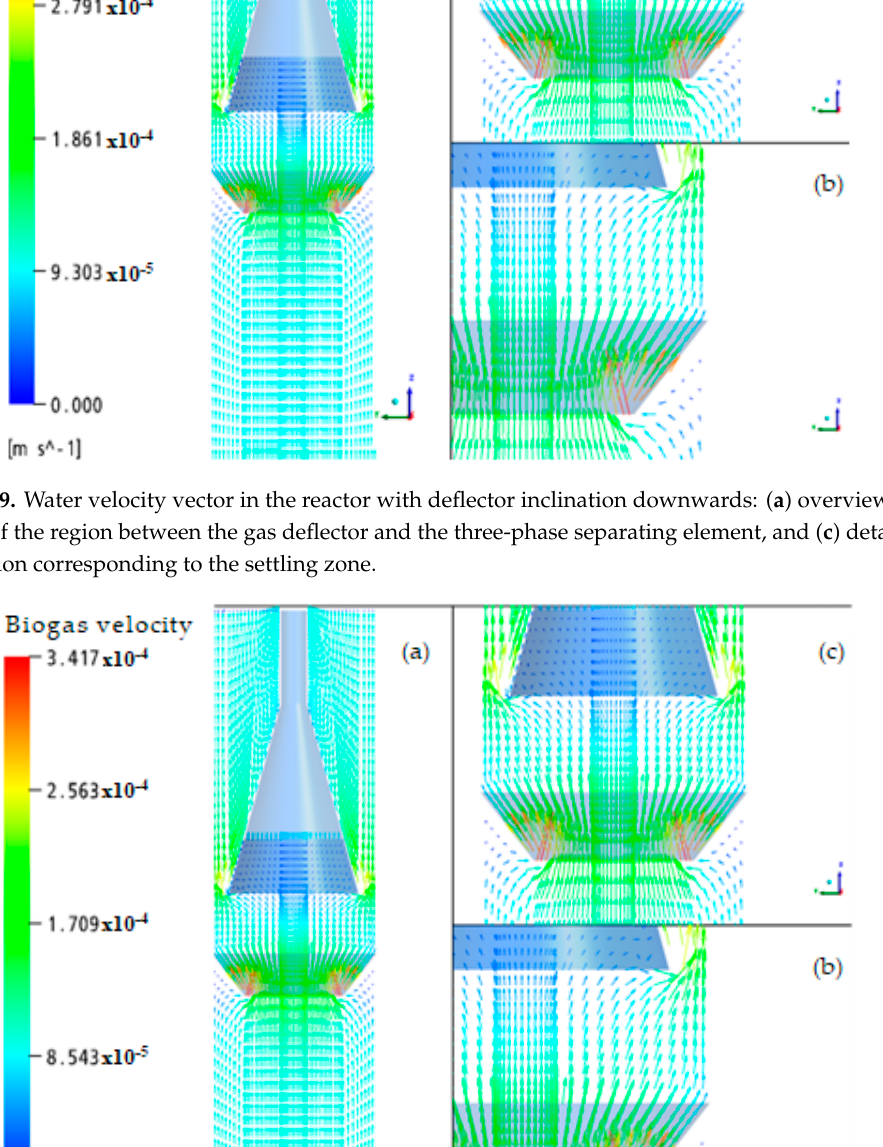
Figure 10. Biogas velocity vector in the reactor with deflector inclination downwards: ( a ) overview, ( b ) detail of the region between the gas deflector and the three-phase separating element, and ( c ) detail of the region corresponding to the settling zone.